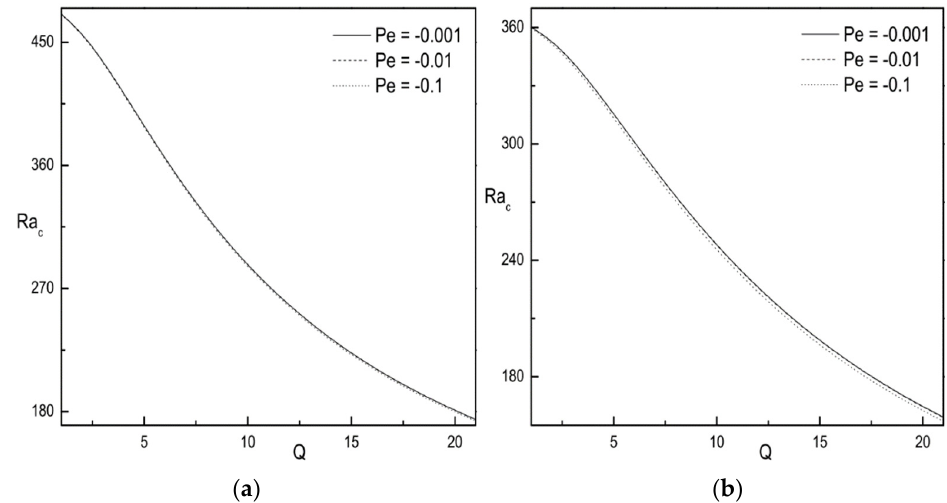
Coatings 2022 , 12 , x FOR PEER REVIEW Figure 3. Dependence of Ra c on Q for ( a ) Da = 0.01 and ( b ) Da = 0.1. Figure 3. Dependence of Ra c on Q for ( a ) Da = 0.01 and ( b ) Da = 0.1.